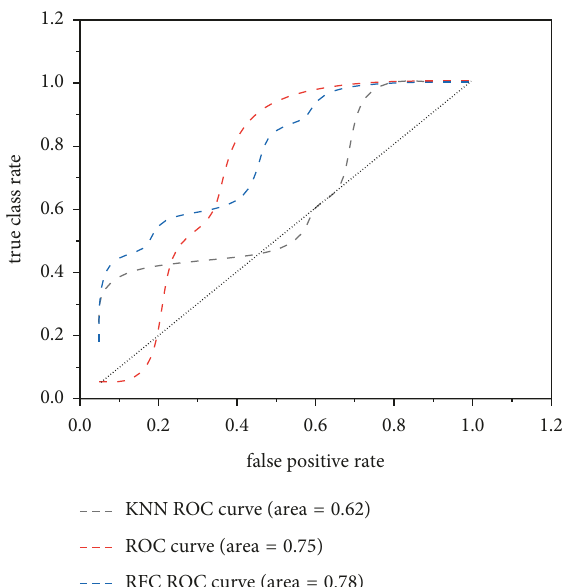
Figure 9: ROC curves of models KNN, LR, and RFC to identify relaxation and high-stress states.